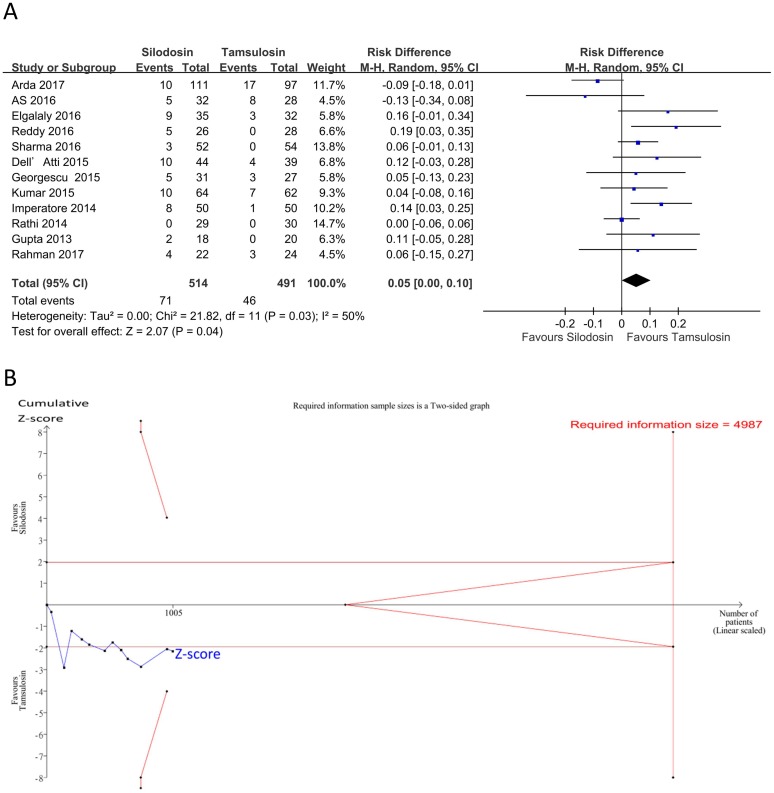
Forest plot and trial sequential analysis for retrograde ejaculation.A: Forest plot. RD, risk difference; CI, confidence interval. B: Trial sequential analysis assessing the effect of silodosin versus tamsulosin on retrograde ejaculation. The risk of a type I error was maintained at 5% with 90% power. The variance was calculated from data obtained from the trials included in this meta-analysis. A clinically meaningful intervention effect for stone expulsion was set to a 50% relative risk reduction based on the assumption of 9.4% proportion of the control group.